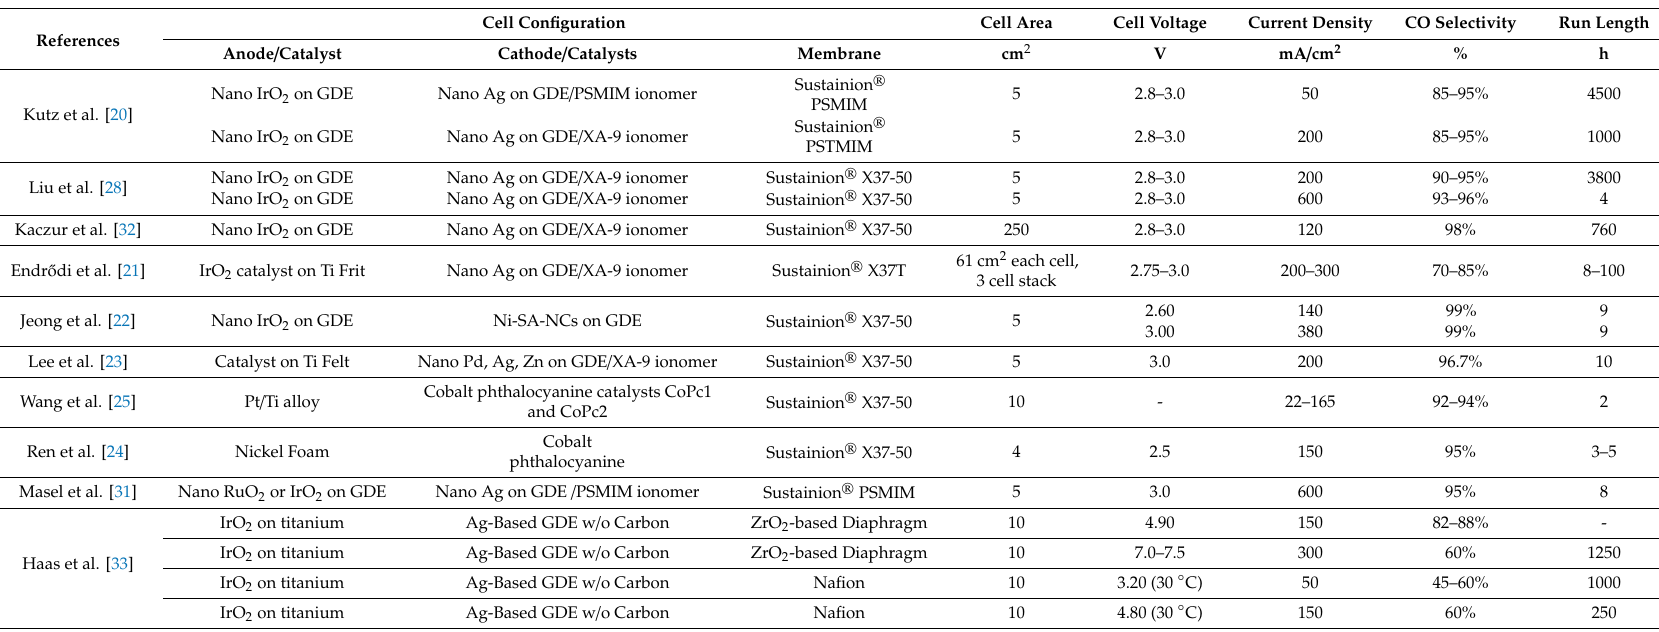
Table 1. A selection of data comparing the electrolysis of CO 2 to CO using Sustainion ® anion membranes and other